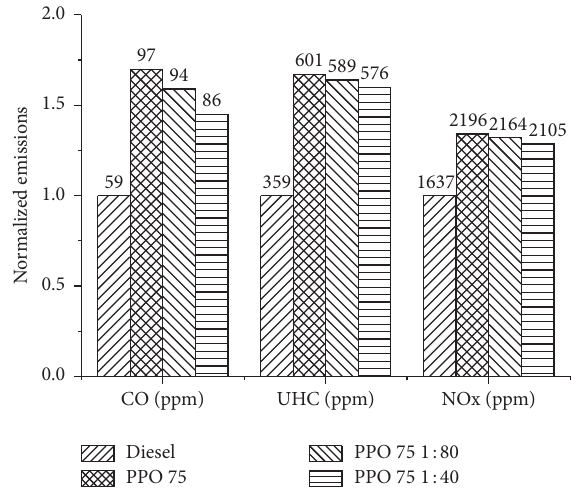
and to 33.5% with a ratio of 1 : 40 fuel additive. This result indicates that the earlier start of combustion improves the conversion of heat (released from the fuel) to kinetic energy on the pistons. There is still room for improvement which is possible to be covered by adding a dedicated cetane number fuel